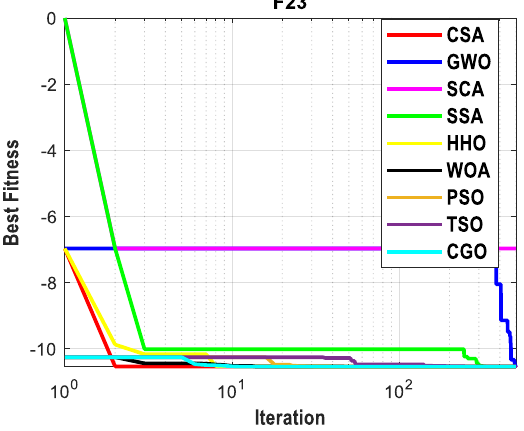
Figure 4. Convergence curves of the applied algorithms.